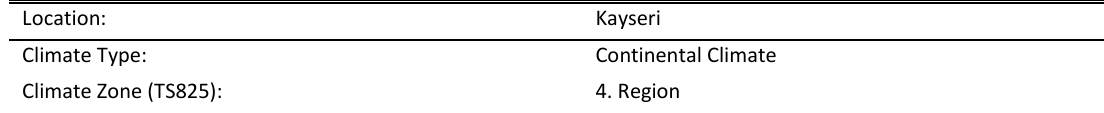
Table 2 Location features of reference building for